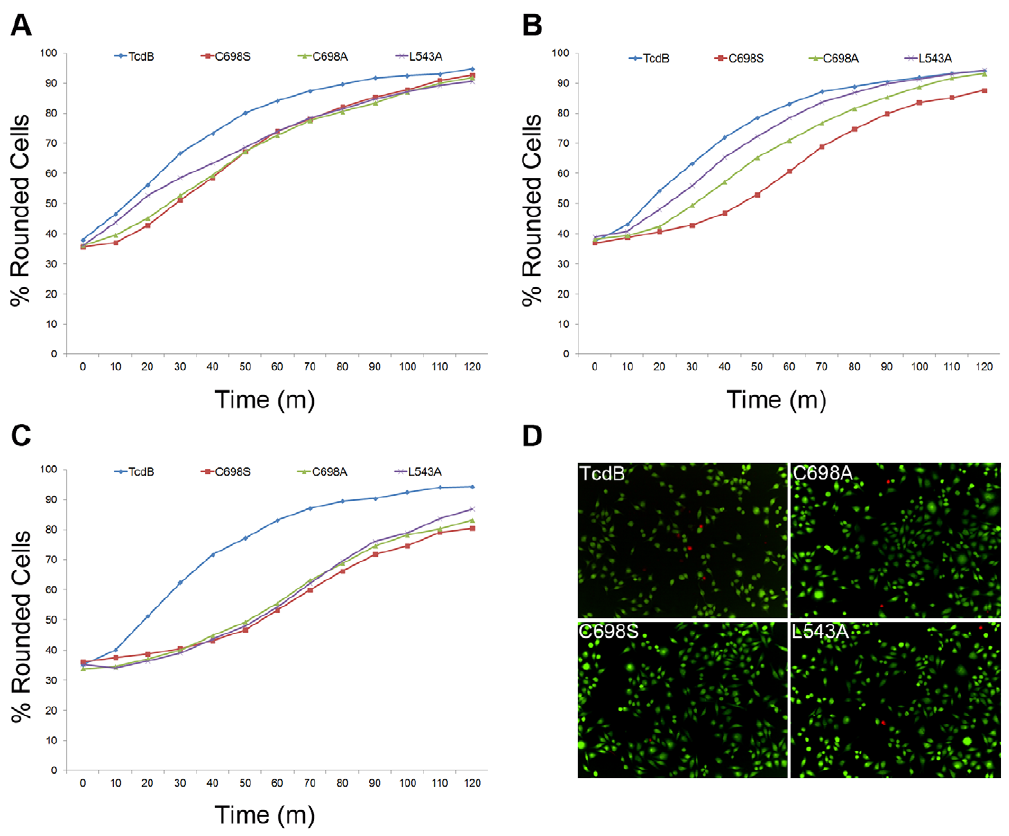
Figure 5. TcdB and TcdB autoprocessing mutants cause cell rounding with concentration dependent kinetics. HeLa cells were treated with multiple concentrations of wild-type and mutant TcdB proteins and imaged every 10 minutes over a 2 hour time course. The percentage of round cells was quantified over six fields for each concentration and time point. The kinetics of rounding induced by TcdB and the TcdB autoprocessing mutants is shown at concentrations of A , 10 pM. B , 100 fM and C , 1 fM. D , Representative images of cells treated with 1 fM TcdB and TcdB autoprocessing mutants for 50 minutes. Green cells are alive; red cells are dead. Images were collected with an Opera High-Throughput Confocal Screening Microscope in an environment-controlled chamber at 37 u C, 5% CO 2 . Round cells were defined as having an area less than 500 um 2 and a width-to-length ratio of less than 0.4. Analysis was performed using Columbus Analysis software.